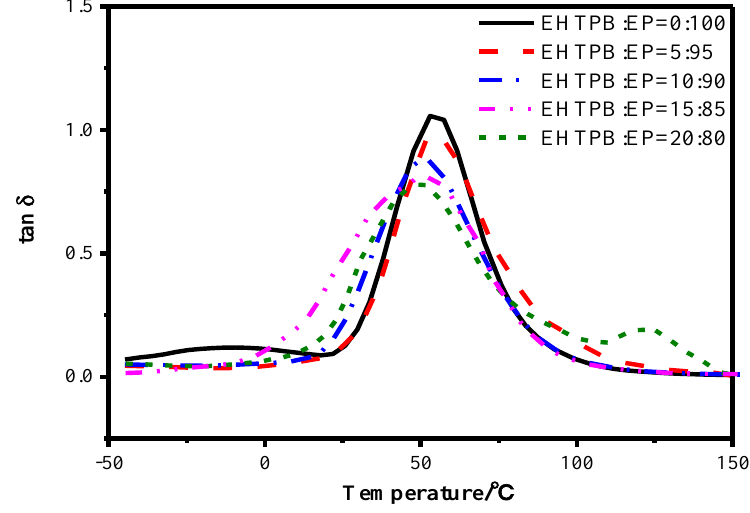
Figure 11. Loss tangent curves of the epoxy resin with different w(EHTPB)/w(EP) ratios. Table 3. DMA data of the epoxy resin with different w(EHTPB)/w(EP) ratios.